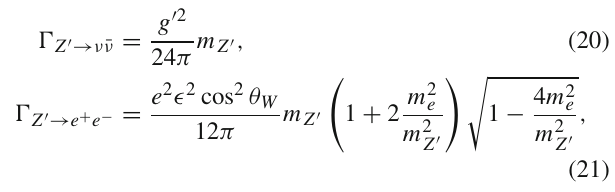
Fig. 2 The branching ratio of the Higgs invisible decays, h → Z (cid:2) Z (cid:2) and h →